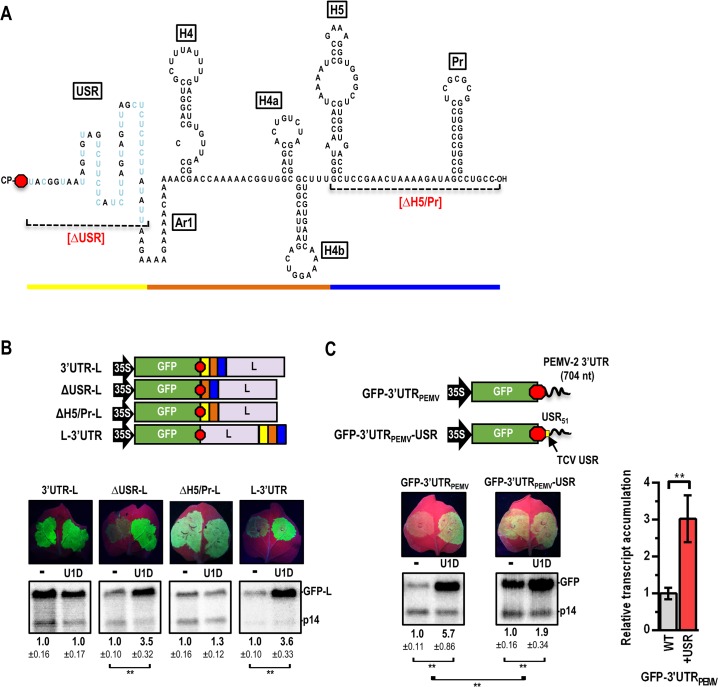
The USR at the 5’ end of the TCV 3’ UTR is critical for NMD-resistance and can protect an unrelated NMD-sensitive transcript.(A) Secondary structure of the TCV 3’ UTR. USR pyrimidine residues are colored blue. Deletions that were introduced in the 3’UTR-L reporter are indicated. (B) Top, deletion-containing constructs. The 3’ UTR was also relocated to the 3’ terminus of GFP-L (L-3’UTR). Bottom, accumulation of transcripts in agroinfiltrated N. benthamiana in the presence and absence of U1D along with p14. Data are from three independent infiltrations and standard deviation is shown. See legend to Fig 2B for additional information. (C) Top, constructs used to assess if PEMV-2 contains an NMD-protective region in its 3’ UTR. GFP-3’UTRPEMV, the 3’ UTR of PEMV-2 was placed downstream of GFP. GFP-3’UTRPEMV-USR, the first 51 nt of the PEMV-2 3’ UTR were replaced by the analogous segment of the TCV 3’ UTR (yellow). Bottom, accumulation of transcripts in agroinfiltrated N. benthamiana in the presence and absence of U1D along with p14. Data are from six leaves and standard deviation is shown. See legend to Fig 2B for additional information. Fold-increase in RNA accumulation with the USR was determined by comparing the fold-increase with U1D between GFP-3’UTRPEMV and GFP-3’UTRPEMV-USR.